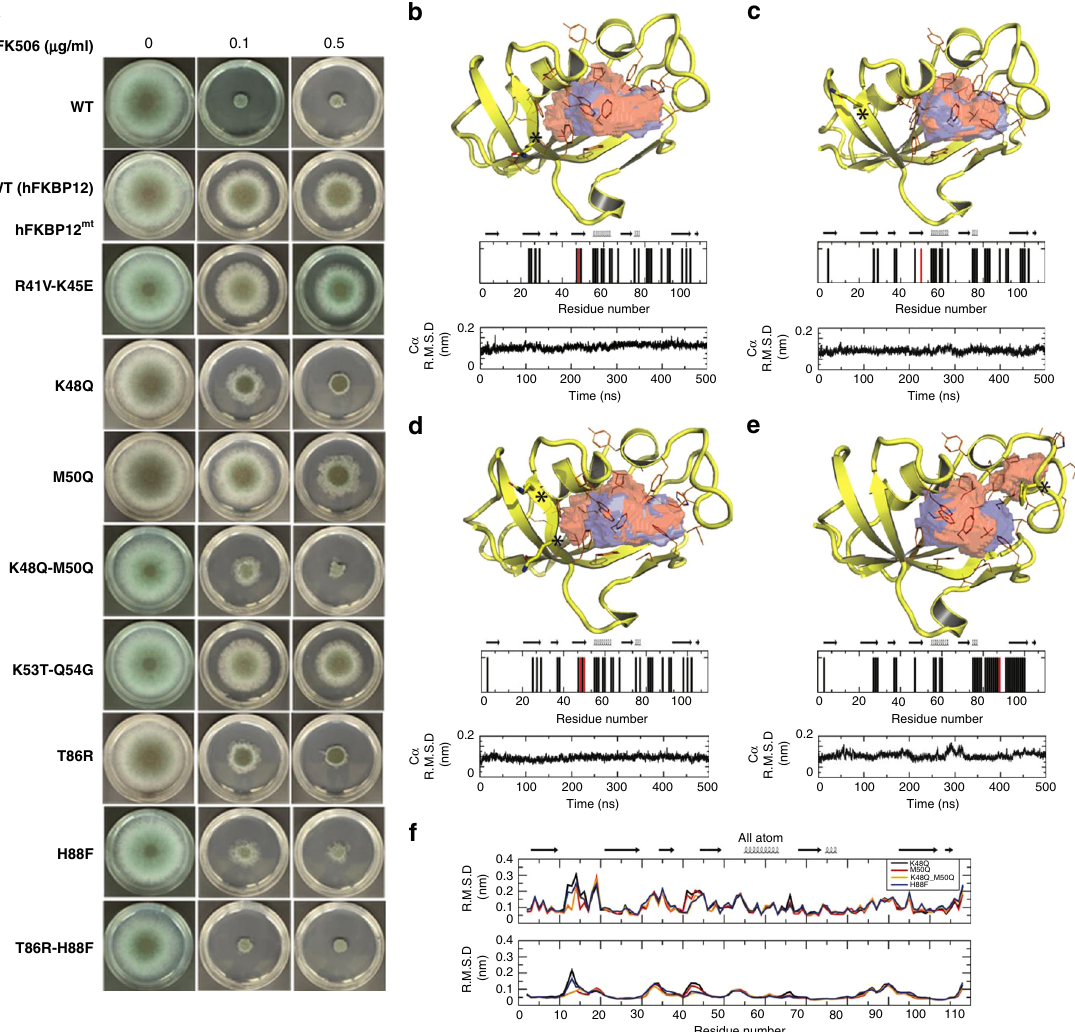
Fig. 4 FK506 susceptibility and structural implication of hFKBP12 mutants. a Growth of the hFKBP12 mutants in the absence and presence of FK506 for 3 days at 37°C ( b K48Q, c Q50M, d K48Q – Q50M, e H88F) The FK506-binding pocket of WT (blue surface) and the pocket resulting from the mutation (red surface) are shown. Mutation site is denoted with a “ * ” and shown in stick format (red bar in bar graph), while residues comprising the binding pocket are shown in orange lines (black bars in bar graph). Stability and quality of the simulation is shown in the C α RMSD plot. f All atom (top) and backbone (bottom) RMSD denoting the structural variation due to the mutation compared to the WT structure (1FKF-monomer). See also Supplementary Figs. 6 and